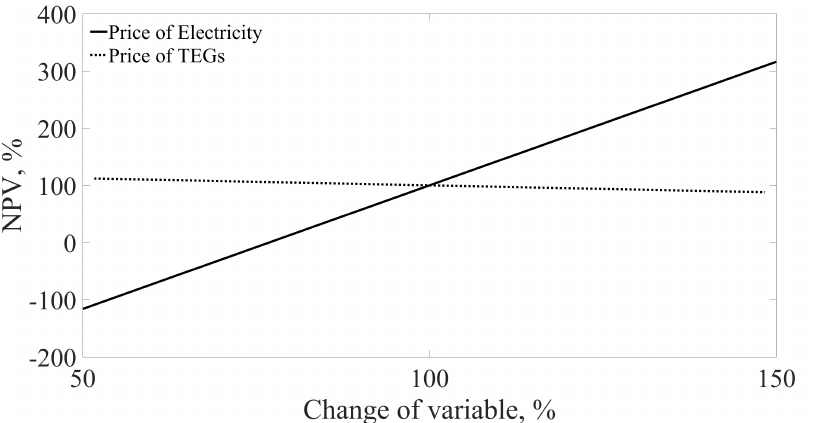
Figure 16. Sensitivity of the net present value of the investment with Material 2 on the price of electricity and that of the TEG